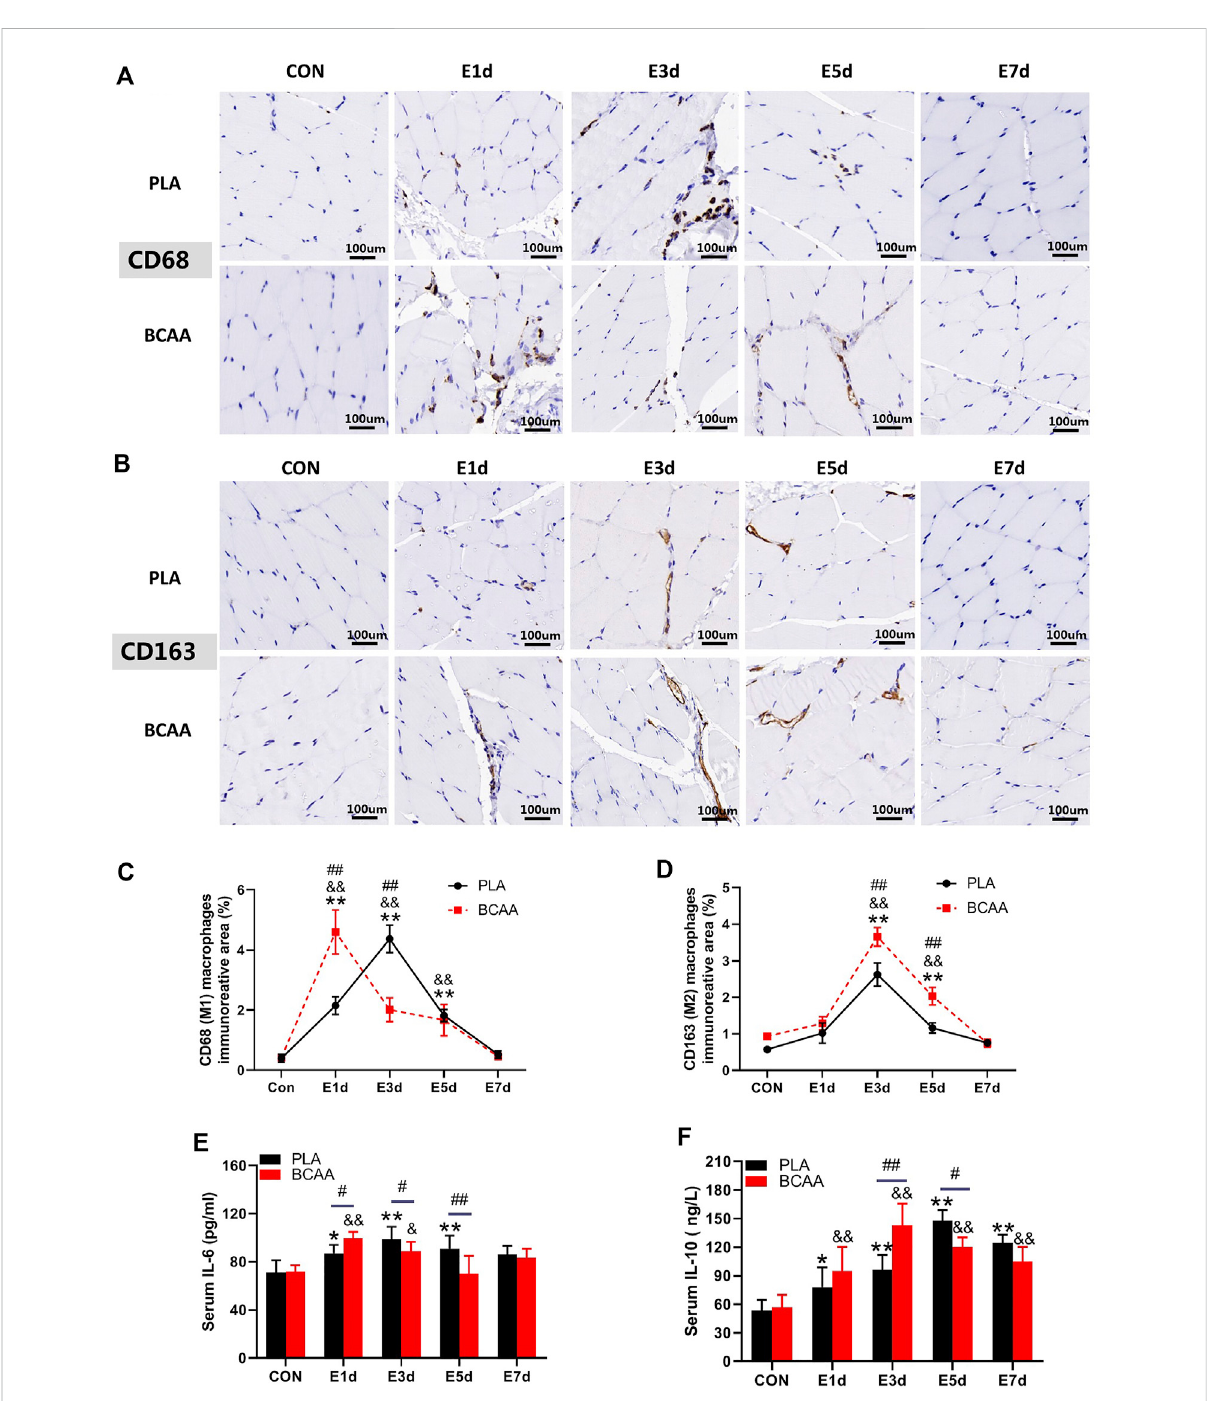
FIGURE 2 BCAAspromoteM1andM2polarizationofmacrophagesduringEIMDrepair. (A – D) BCAAspromotedCD68/CD163expressioninmacrophages during EIMD repair as revealed by immunohistochemical analysis (Scale Bar = 100 um). (E,F) The effects of BCAAs on serum levels of in fl ammatory cytokines, namely, IL-6, and IL-10 during EIMD repair. Data are presented as mean ± SEM.* p < 0.05, ** p < 0.01 vs. PLA CON; & p < 0.05, && p < 0.01 vs. BCAA CON; # p < 0.05, ## p < 0.01 between PLA and